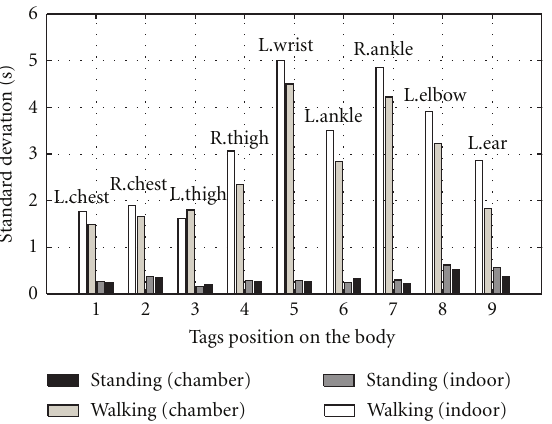
Figure 7: Comparison of standard deviation ( σ ) of nine di ff erent on-body radio channels for standing and walking scenarios mea- sured in the chamber and